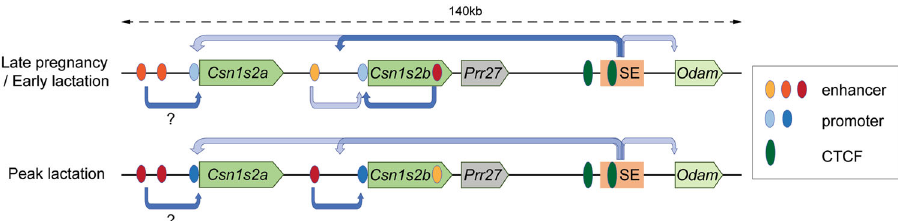
Fig. 7 Proposed model of the activation of the Csn1s2a/b locus during pregnancy and lactation. The Csn1s2b gene is under the control of three distinct enhancers; a distal enhancer controlling gene expression throughout lactation, an intronic enhancer active at late pregnancy and early lactation, and a super-enhancer (SE) required for the activation of the Csn1s2b locus. While the SE has limited in fl uence on the expression of the Csn1s2a and Odam genes, it does not activate the Prr27 gene in mammary tissue. Two candidate enhancers have been identi fi ed in the Csn1s2a distal region, but their function has not been validated through experimental genetics. The color intensity of promoter and enhancer elements at late pregnancy and peak lactation re fl ects their relative strengths. Darker colors indicate increased strength. Candidate Csn1s2a enhancer and promoter elements are shown but their biological strength is not known. CTCF binding sites have been identi fi ed 38